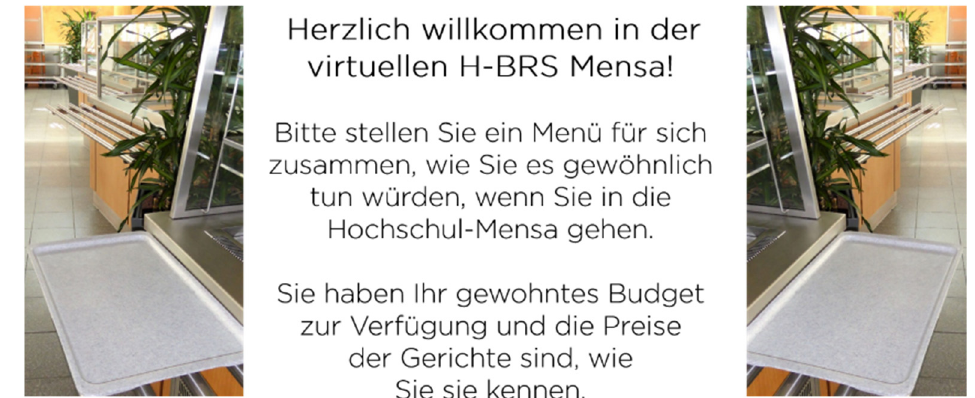
Figure 1. Online food choice scenario depicting the task of composing a typical meal as participants normally would. Participants were asked to imagine having their usual budget as well as the usual prices of the dishes).